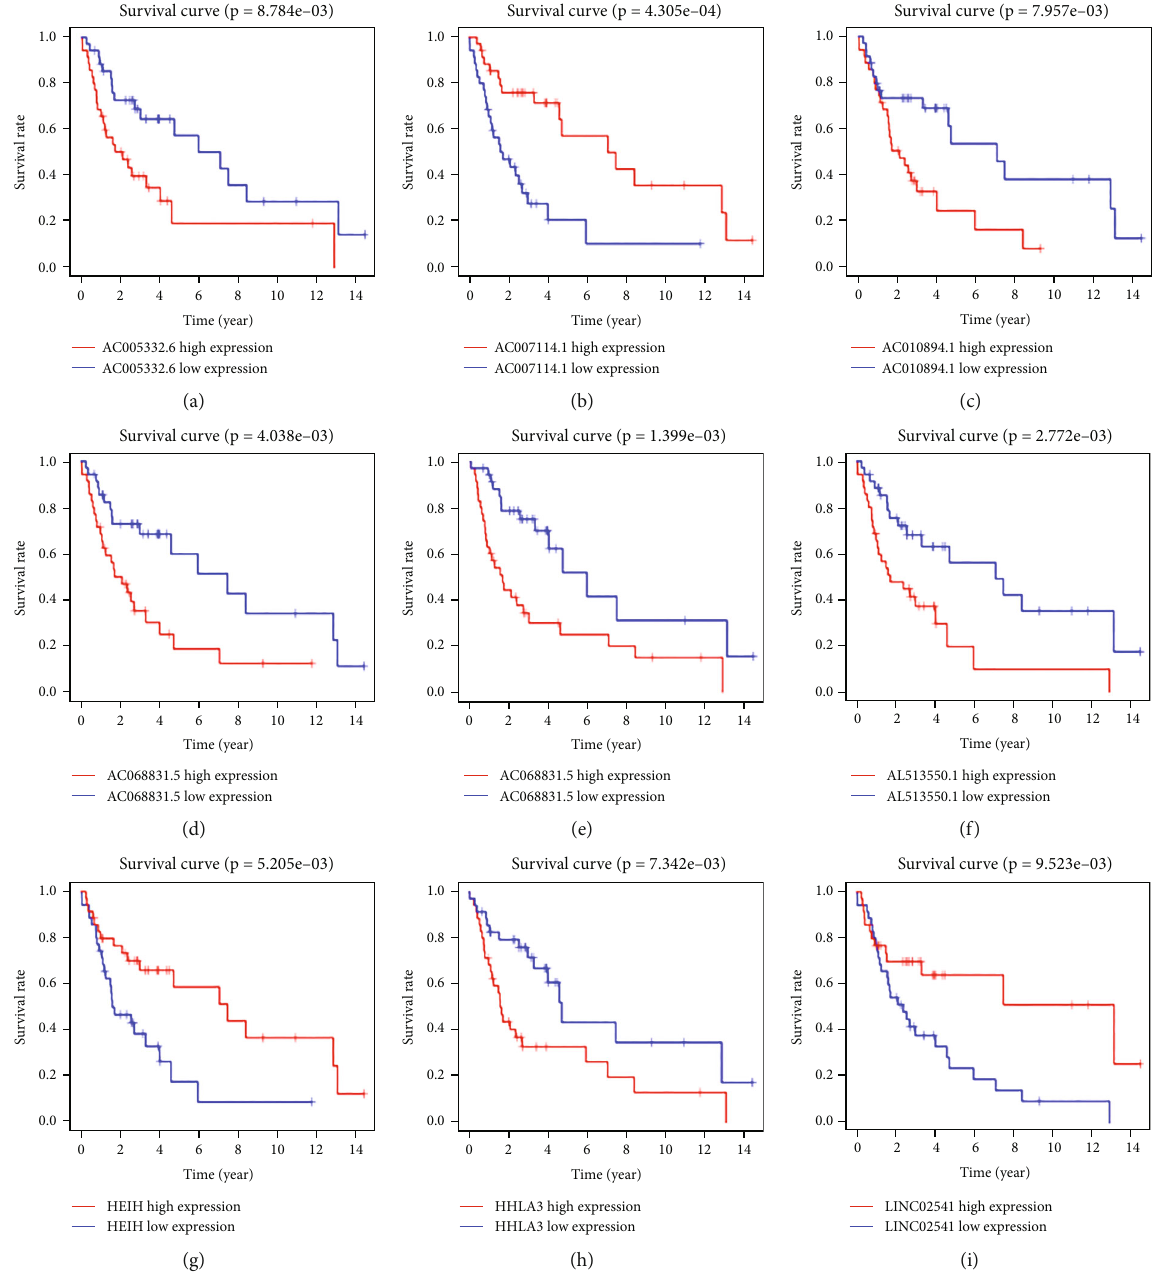
Figure 3: The survival curve of high (red) and low (blue) expression groups of m7G-related prognostic lncRNAs. Abscissa: survival years of patients; ordinate: survival rate of